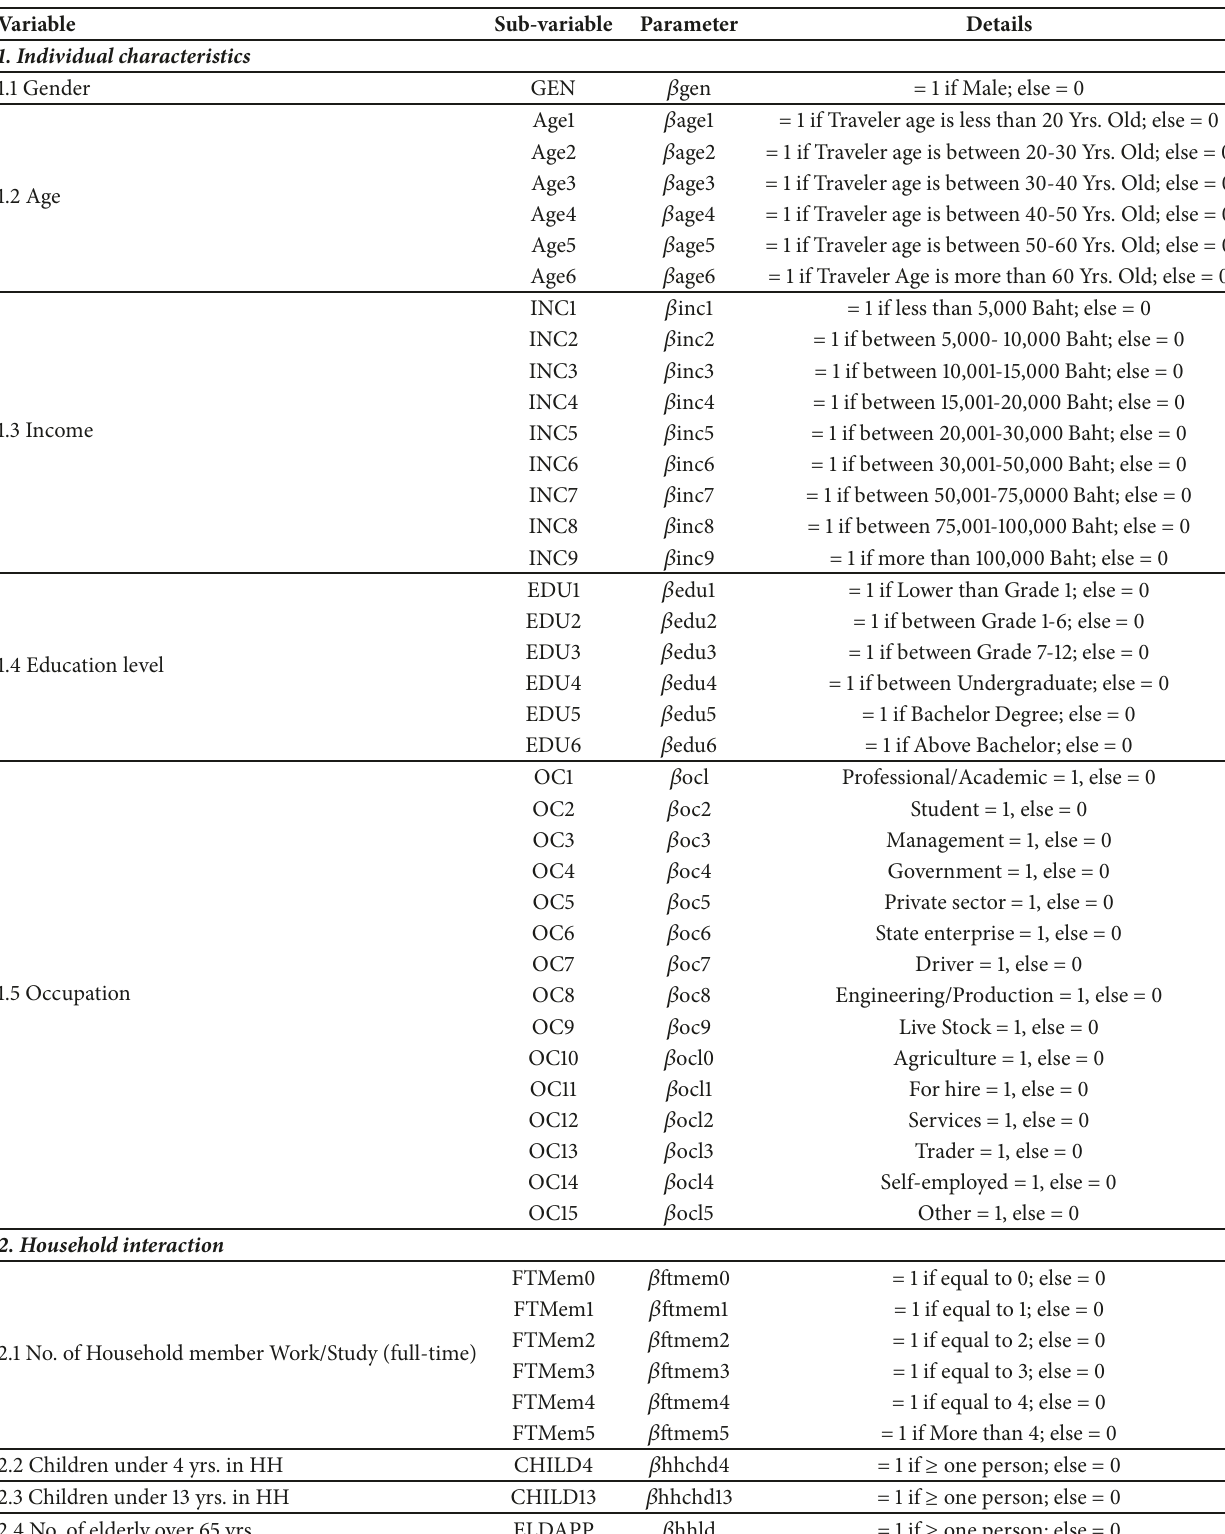
Table 1: Definition and parameter abbreviation of each